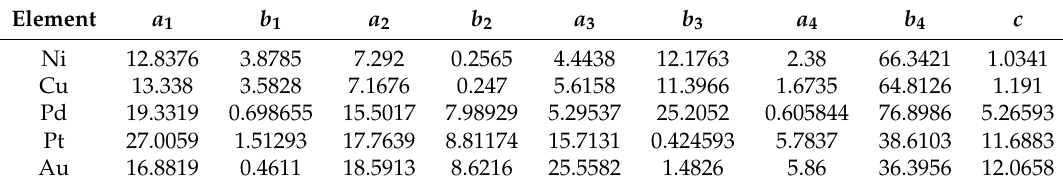
Table A3. Equation (3) has been used to estimate the atomic scattering factor. For this purpose the following coefficients were used [32].